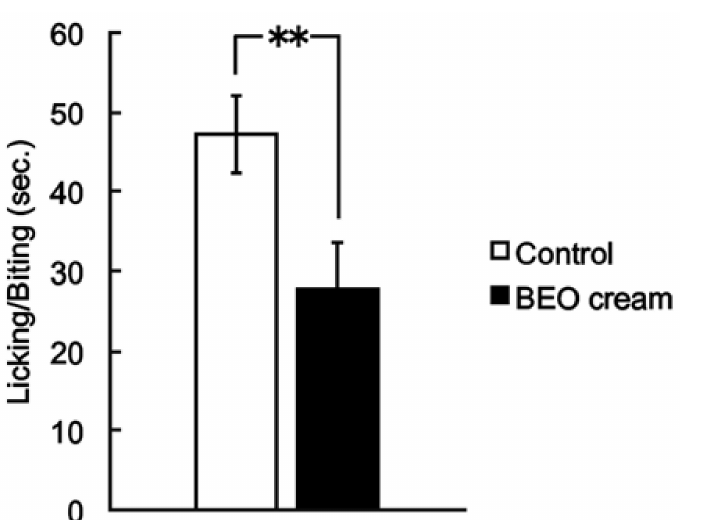
Figure 2. Antinociceptive effect of topical application of NanoBEO (1 mg/mouse) on capsaicin- induced licking/biting behavior. The duration of licking/biting induced by capsaicin has been determined using the 5-min period starting immediately after the injection of capsaicin. Empty cream (1 mg/mouse) has been used as a control and this has failed to affect the capsaicin-induced nociceptive response. Values are expressed as mean ± SEM ( n = 8). Values of p < 0.05 have been considered statistically significant. Improvement over control of 59.26%, ** p <